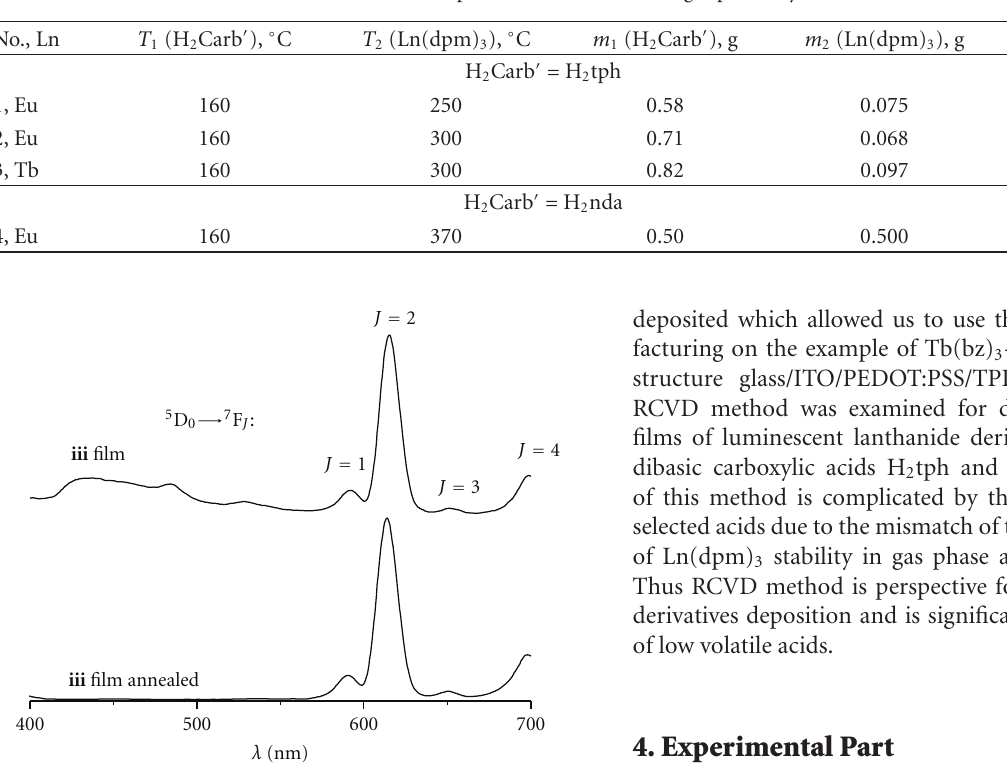
Table 1: Experimental conditions of gas phases syntheses.